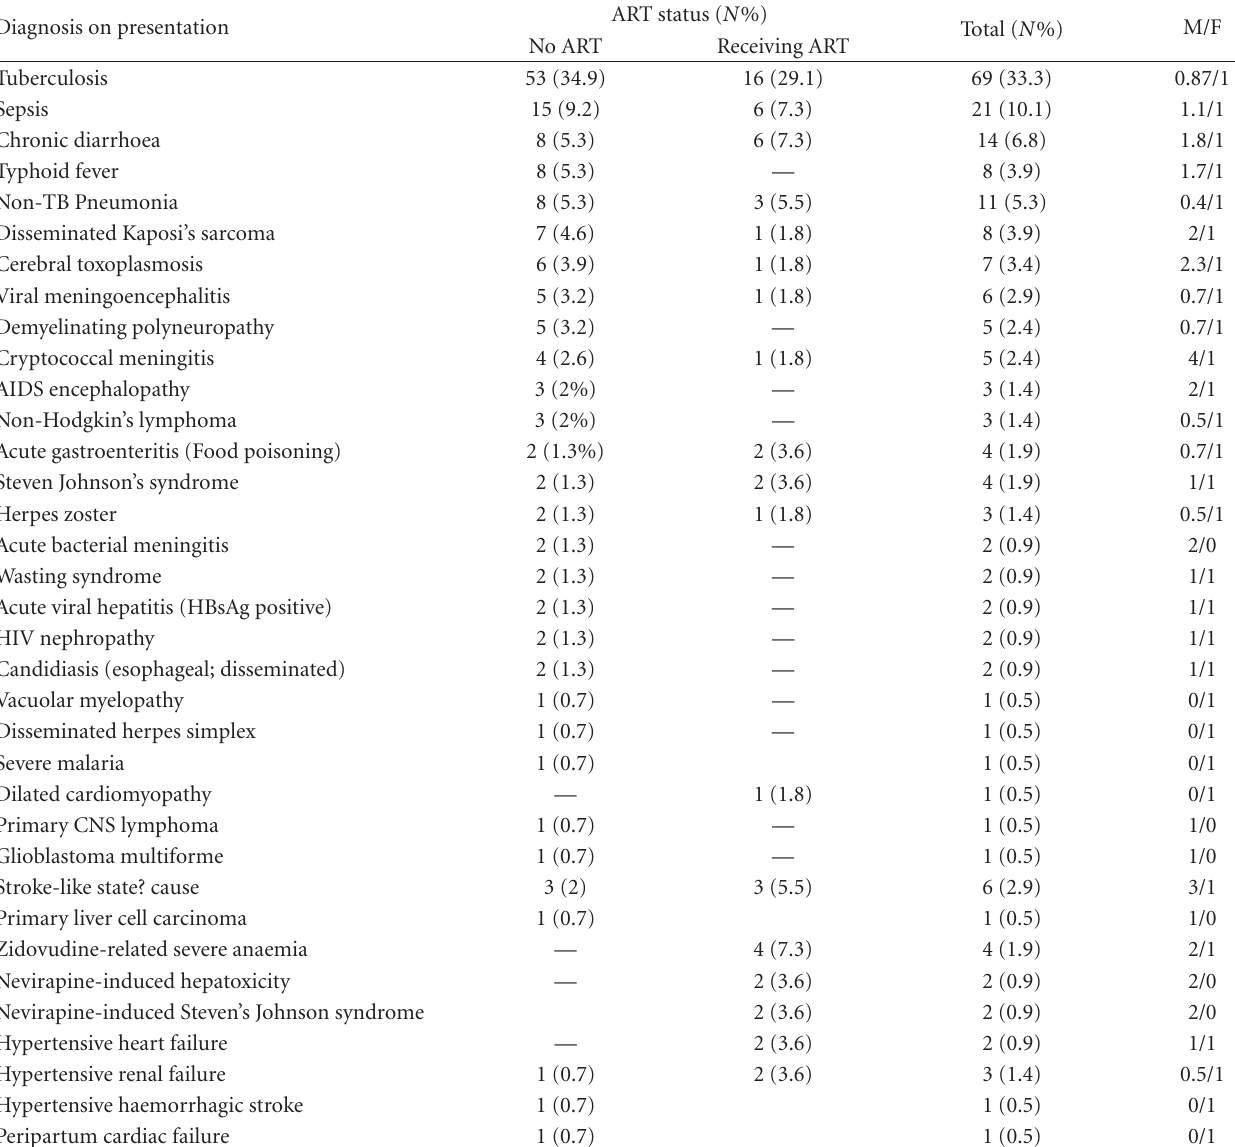
Table 2: Clinical diagnoses of hospitalised HIV/AIDS patients in relation to antiretroviral therapy status and gender. Diagnosis on